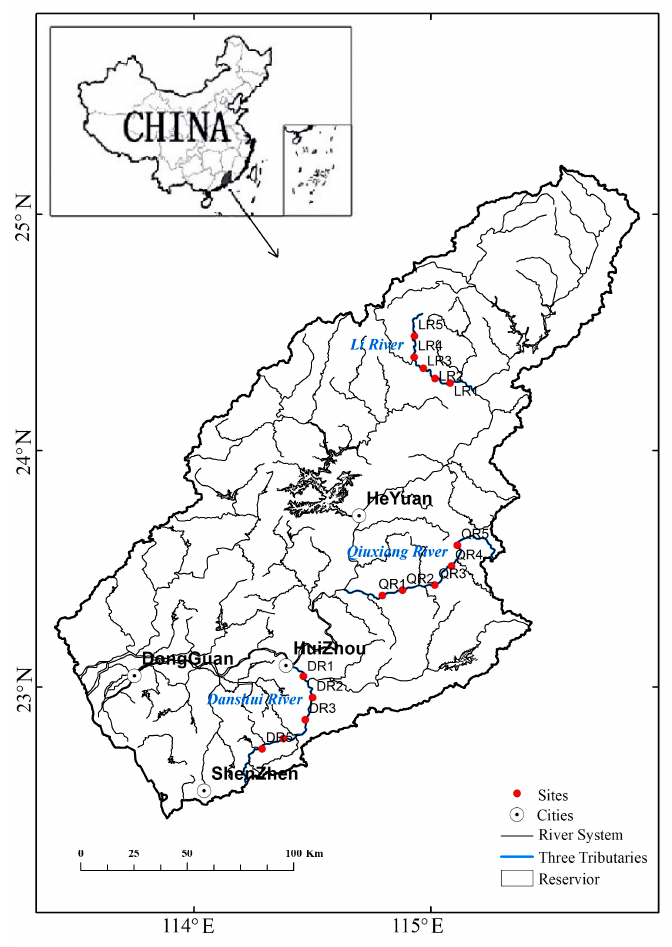
Figure 1. Map of the Dongjiang River Basin and its three tributaries, showing the location of the sampling sites.